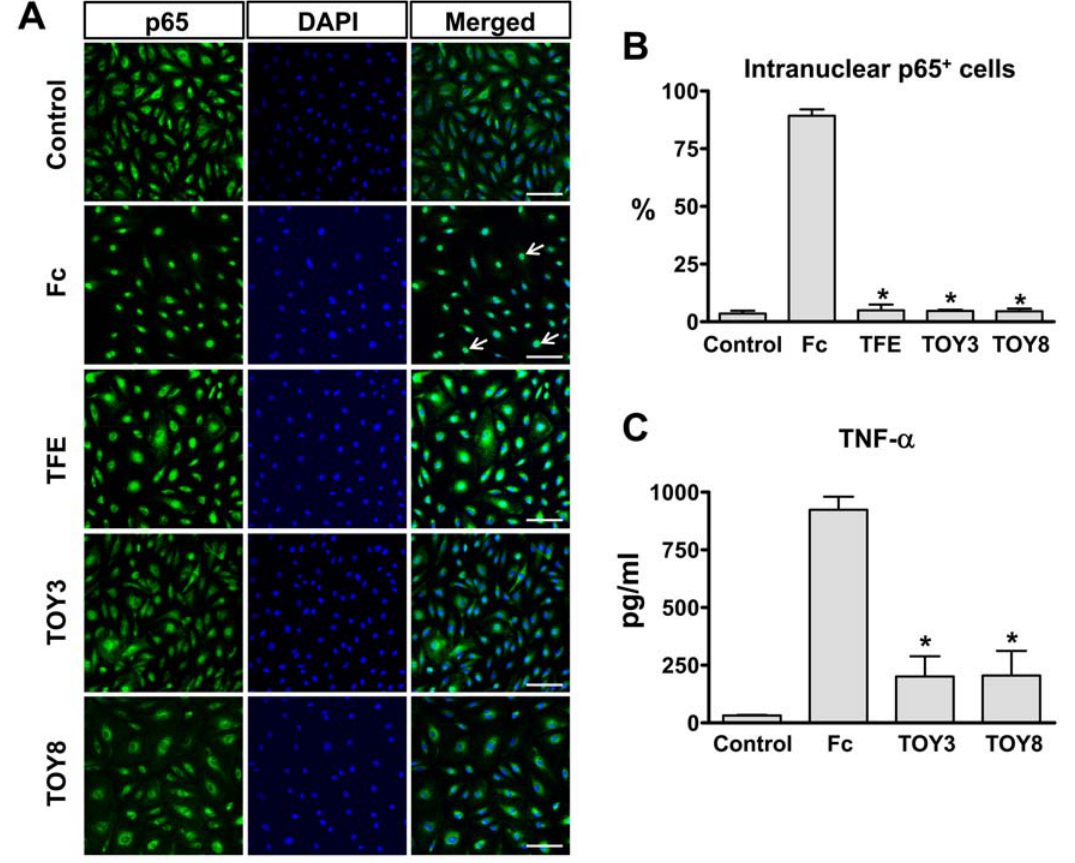
Figure 3. Pre-incubation of TFE, TOY3, and TOY8 markedly attenuates LPS-induced NF- k B activation in primary cultured lymphatic endothelial cells and TNF- a secretion in peritoneal macrophages. LEC (primary lymphatic microvascular endothelial cells derived from human adult dermis) were purchased from Cambrex Inc. (East Rutherford, NJ) and maintained in endothelial cell basal medium-2 with growth supplements (EBM-2 MV). Passage 4–6 LEC were incubated in EBM-2 MV containing 1 % FBS for 8 hr and then with 1 m g/ml of Fc, TFE, TOY3, or TOY8 for 15 min, and then the LEC were treated with LPS (500 ng/ml) for 30 min. ( A ) For determination of NF- k B activation, nuclear translocalization of p65 (a subunit of NF- k B) was analyzed by immunostaining (green). Nuclei were counterstained with DAPI (blue). Arrows indicate nuclear translocalization of p65. Scale bars, 100 m m. ( B ) Cells positive for p65 intranuclear staining (white arrows) were counted among 100 cells arbitrarily chosen in 4 different regions, and the values presented as a percentage of the total cell number. Bars represent means 6 S.D. ( n =4). *, P , 0.05 versus Fc. ( C ) Primary cultured macrophages from mouse peritoneal cavity were pre-treated with 1.0 m g/ml of Fc, TOY3, or TOY8 for 30 min, and then were treated with LPS (100 ng/ml) for 4 hr. Culture media were sampled, and levels of TNF- a were measured. Bars represent means 6 S.D. ( n =5). *, P , 0.05 versus Fc.